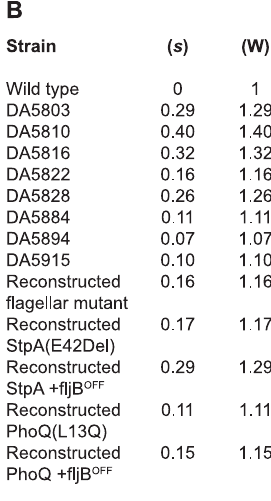
Figure 1. Competitive indexes of reconstructed and parental mutants.